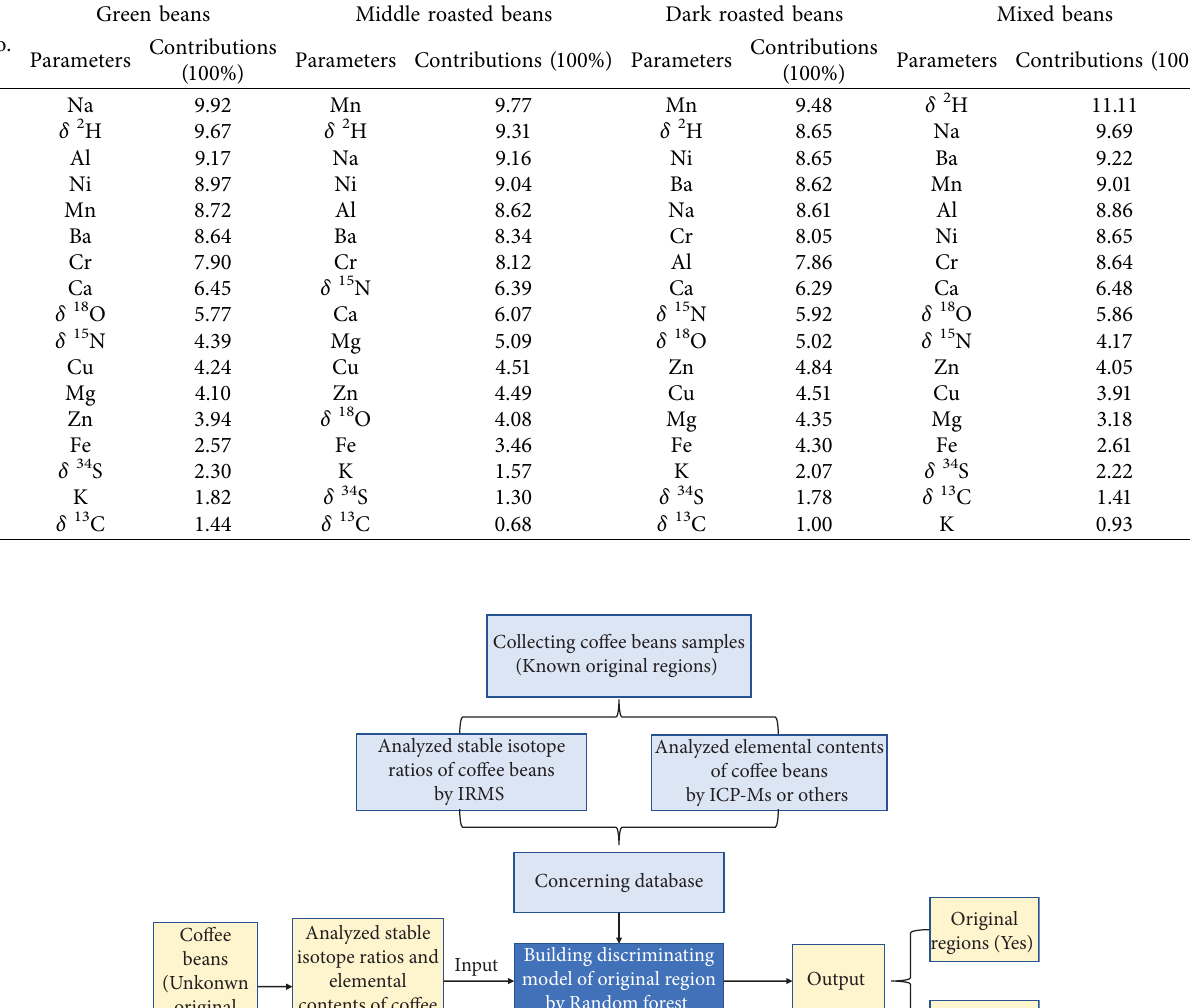
Table 11: Seventeen parameters of variables on random forest analysis of diferent degree cofee beans from six diferent origins. Green beans Middle roasted beans Dark roasted beans Mixed beans No.